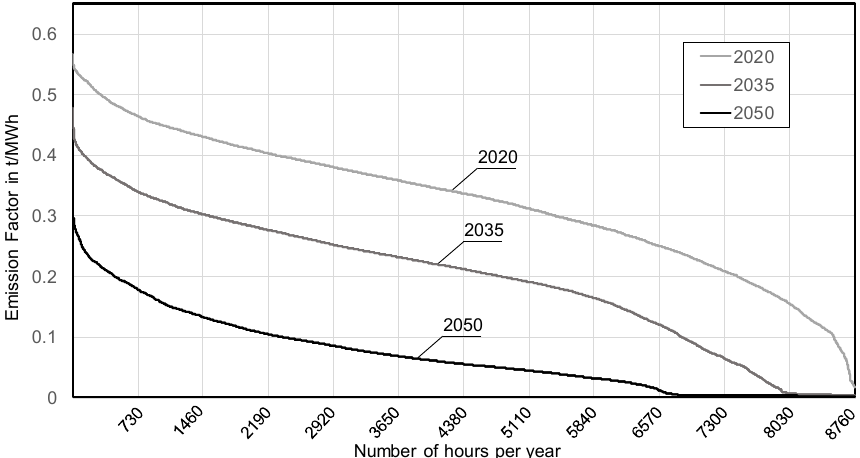
Figure 7. Year duration line: hourly emission factor of electricity (mix) in tons of CO 2 per MWh; CHP allocation method: Carnot.